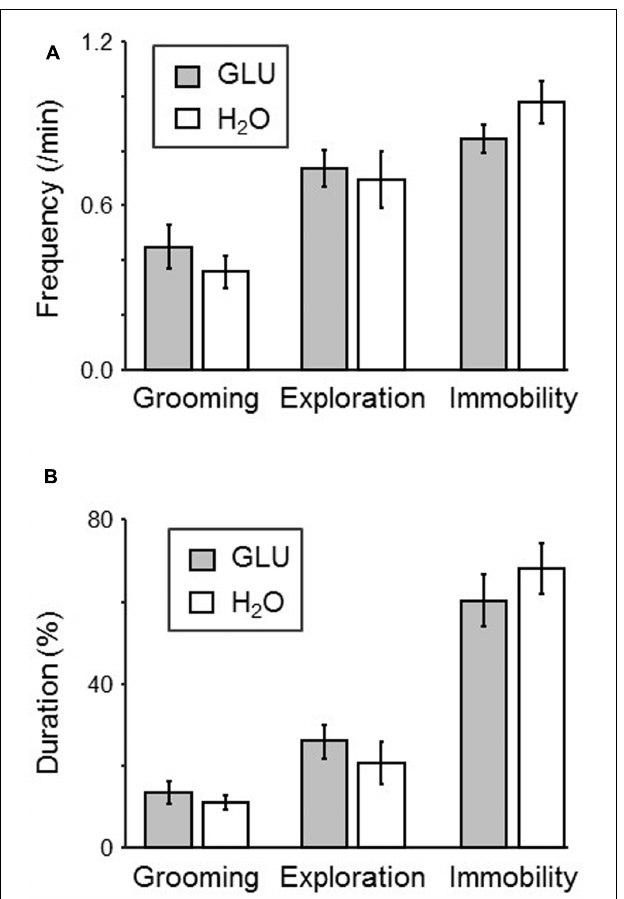
FIGURE 3 | Comparison of behaviors in the dark-period of the test session between H 2 O and GLU groups. (A,B) Frequency (A) and duration (B) of each behavior (grooming, exploration, and immobility). No significant difference between the groups was found.